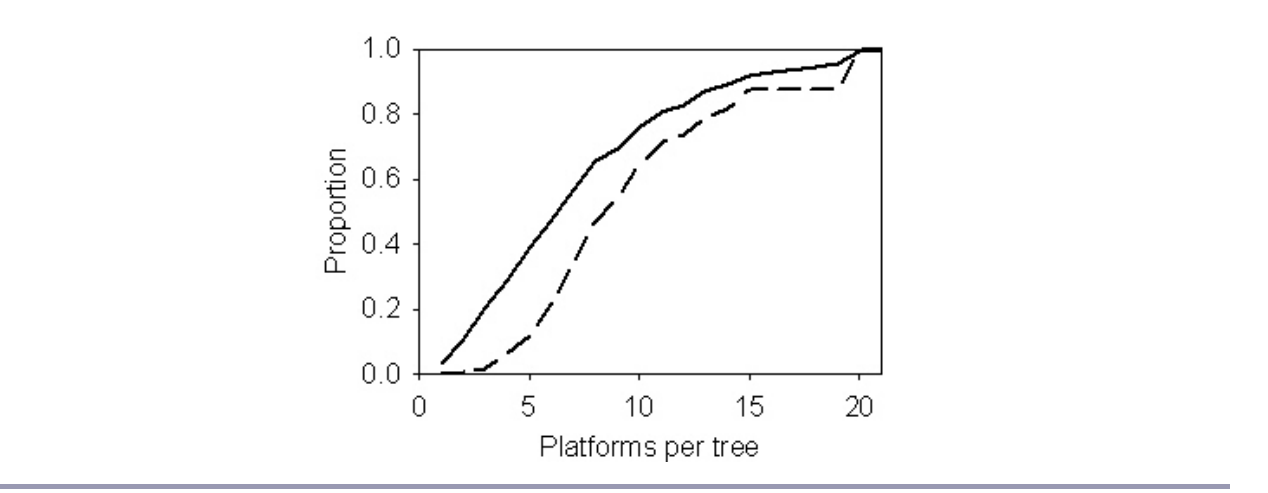
Fig. 1. Cumulative proportion of platforms in non-nest trees (solid line) and platforms in nest trees (dashed line) as a function of trees with a given number of platforms. Although the distributions are not significantly different (Kolmogorov-Smirnov 2-sample test: KSa = 0.79, P = 0.33), trees with fewer than three to four platforms appear to be underused. Platforms n = 2609; platform trees n =